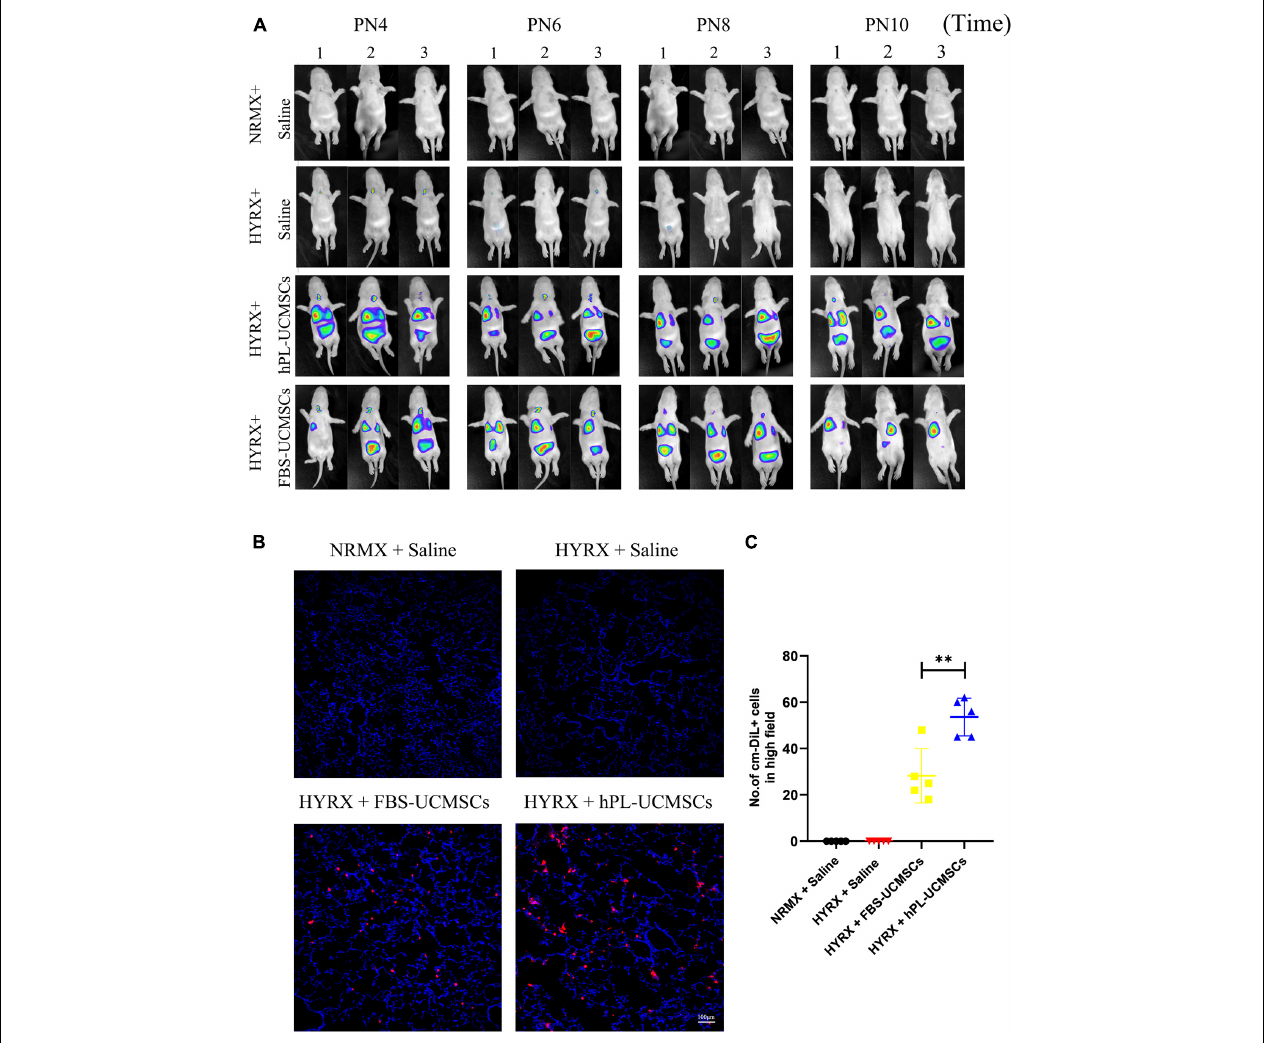
FIGURE 5 | More hPL-UCMSCs were maintained in lung tissue than FBS-UCMSCs. (A) The biodistribution of hPL-UCMSCs and FBS-UCMSCs in rat lung during PN4 to PN10 was detected by In Vivo Imaging System. Rat lung tissue were harvested at PN10 (B) , and the count of administrated cm-DiL + UC-MSCs in lung sections were evaluated from five random high field (C) . Scale bars, 100 µ m. Data are shown as mean ± SEM. n = 5. ∗∗ p <